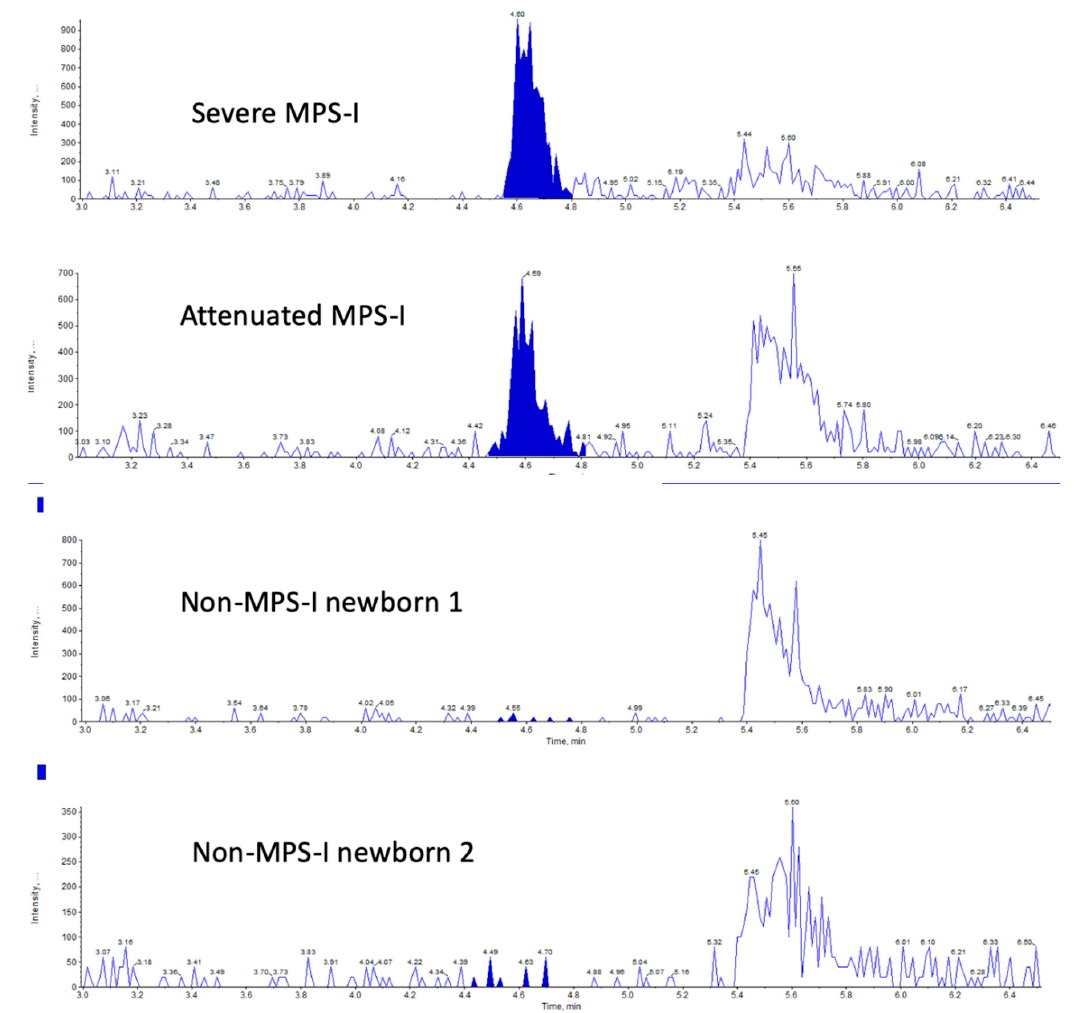
Figure 3. LC-tandem mass spectrometry (MS / MS) traces (multiple reaction monitoring (MRM) signal response versus time) for the endogenous disaccharide marker UA-HNAc(1S) 1-phenyl-3-methyl-5-pyrazolone (PMP) derivative using newborn DBSs from indicated patients.